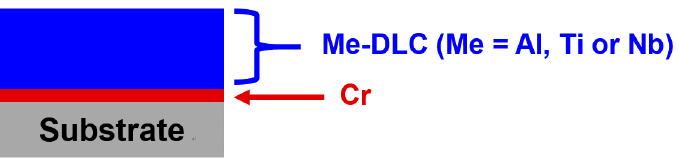
Figure 1. Schematic architecture of Me-DLC coatings.